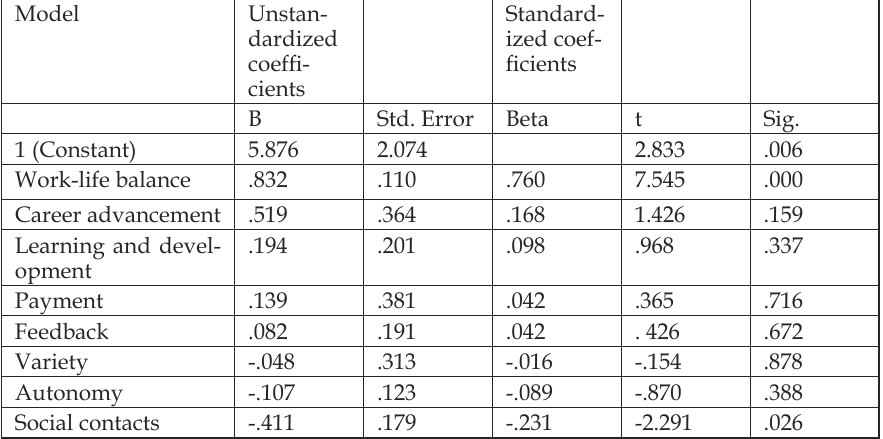
Tab. 12. Predictors of the tendency to leave the organization for the respondents under 35 years. Coef (cid:222)